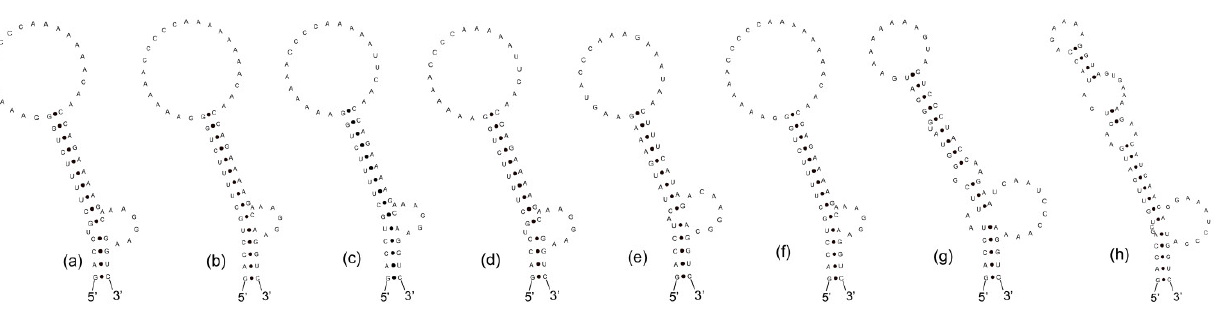
Figure 6. D1–D1′ helix of Ancylothrix strains: ( a ) Ancylothrix rivularis WZU 0009, 0011, 0014; ( b ) Ancylothrix rivularis WZU 0013; ( c ) Ancylothrix rivularis 7PC, 8PC; ( d ) Ancylothrix rivularis 9PC; ( e ) Ancylothrix terrestris 10PC, WZU 0153, WZU 0154; ( f ) Ancylothrix terrestris 13PC; ( g ) Ancylothrix terrestris 11PC; ( h ) Ancylothrix terrestris 12PC.